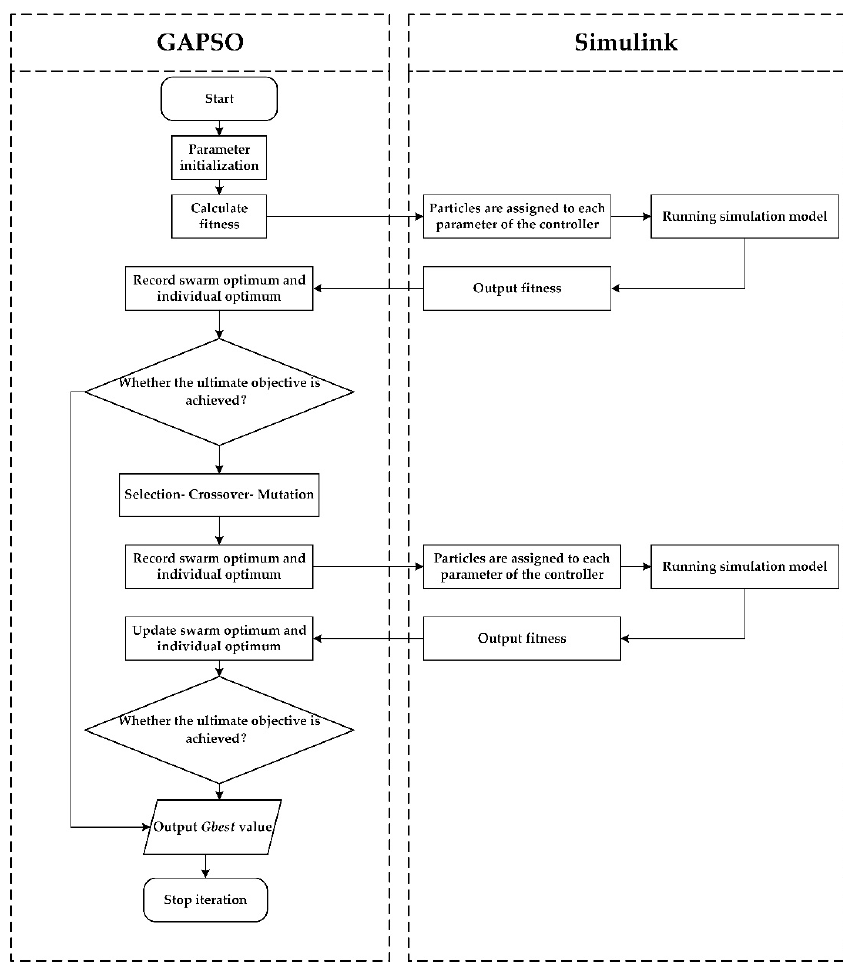
Figure 4. The process of setting control parameters by GAPSO.